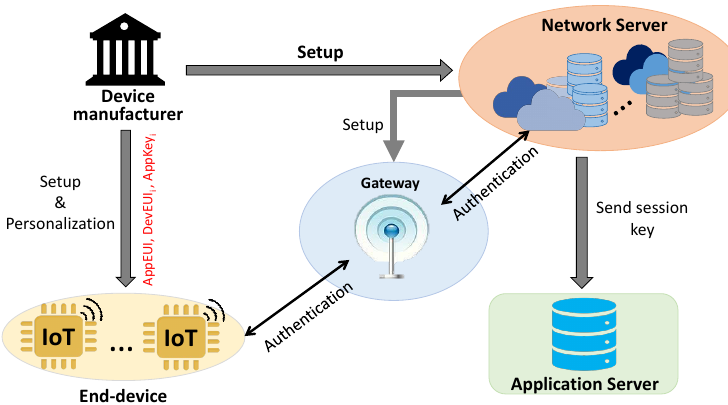
Figure 5. Communication between various entities in the proposed